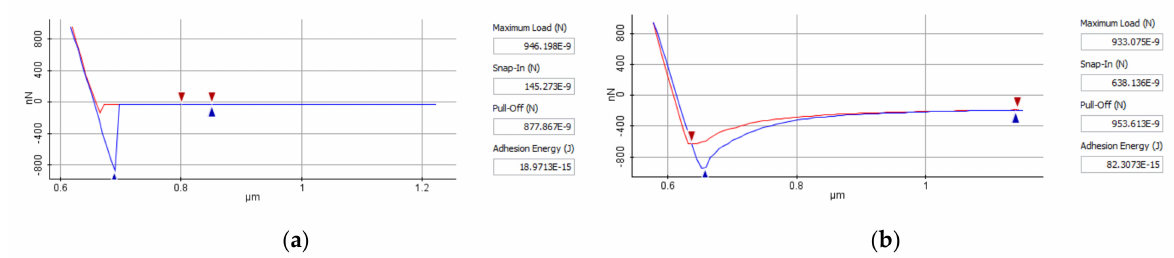
Figure 8. AFM spectroscopy-in-point of SU-8 hard baked at 125 ◦ C, tested at 20 ◦ C ( a ) and 100 ◦ C ( b ).